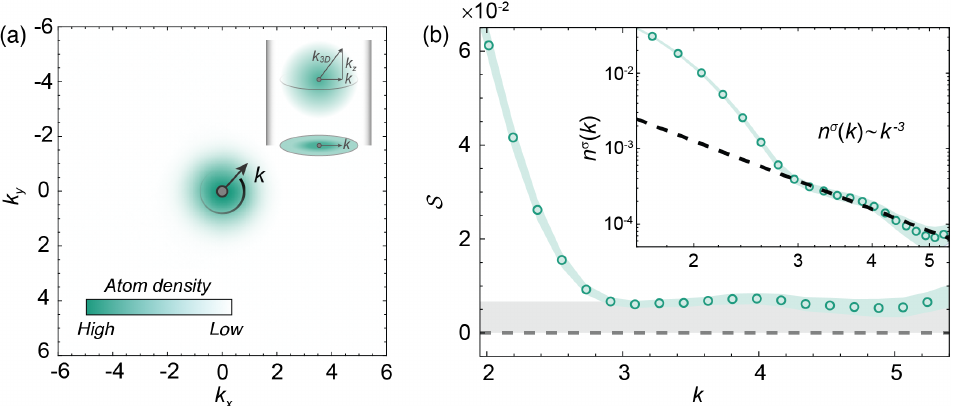
FIG. 2. Measurement of the contact parameter from the momentum distribution. (a) Momentum distribution of 173 Yb atoms consisting of N ¼ 6 nuclear spin states after 4 ms time-of-flight expansion. Dimensionless momentum k here is normalized by the Fermi wave number k F . Note that momentum profile outside k ≃ 2 . 5 has already been subtracted by the momentum profile of the spin-polarized gas ( N ¼ 1 ) with the same total atom number. (b) S ¼ 2 = π · k 3 n σ ð k Þ is plotted as a function of momentum k in units of k F . The inset is the momentum tail of azimuthally averaged atomic distribution n σ ð k Þ in logarithmic scale with a dashed guideline of n σ ð k Þ ∝ k − 3 . The R n σ ð k Þ is normalized as n σ ð k Þ 2 π kdk ¼ 1 . The finite value of the contact is determined from the plateau of the S profile in the range of k ¼ 3 – 4 . The green and gray shaded areas indicate the standard error and the measured value of contact,